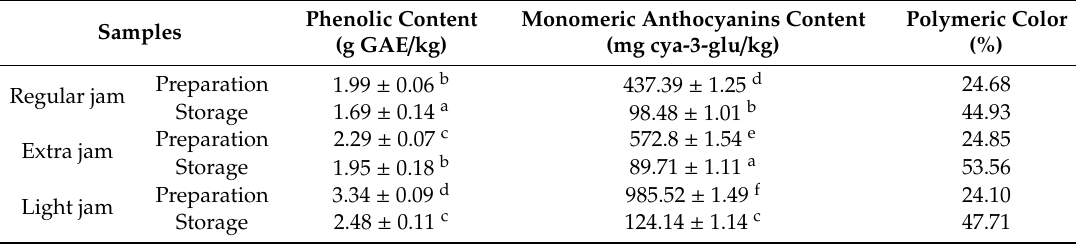
Table 2. Total phenolic, monomeric anthocyanins content and polymeric color of regular jam, extra jam and light jam after preparation and storage at room temperature for eight months.